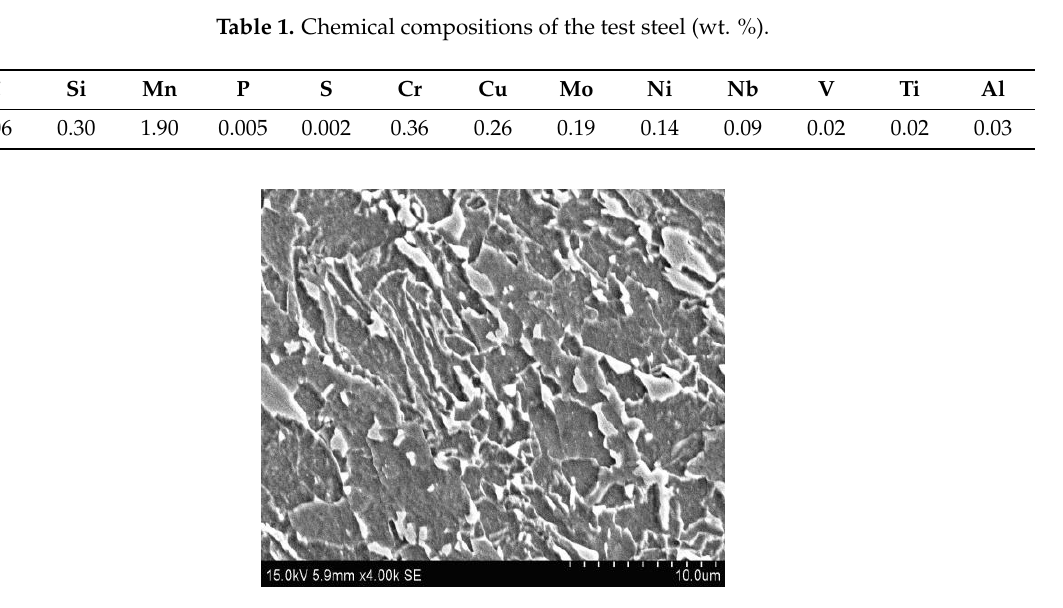
Figure 1. SEM (scanning electron microscope) image of X90 steel with multi-phase: granular bainite (black matrix) + M/A islands (white secondary phase). M/A—martensite/austenite.